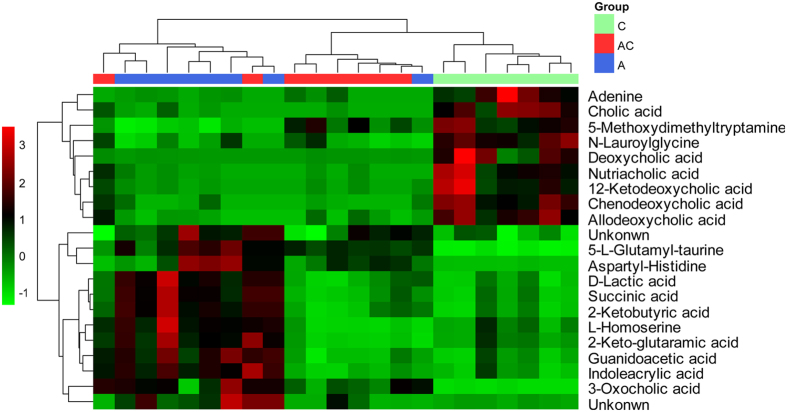
Significant changes in fecal metabolites are expressed as a heatmap showing metabolite changes in all treatment groups, detected by UPLC-Q-TOF/MS.(C) control group, (A) antibiotic group, (AC) CSGS + antibiotic group.